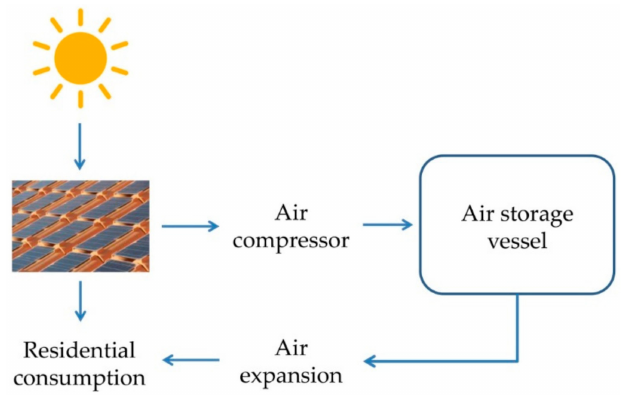
Figure 3. Compressed air energy storage (CAES) system associated with a residential photovoltaic (PV)